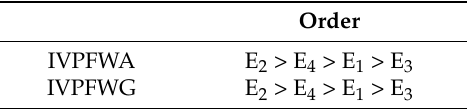
Table 8. Order of the green